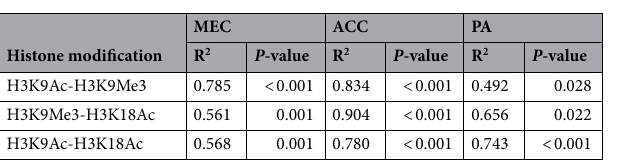
Table 3. Correlation among 3 types of histone H3 modification in salivary gland